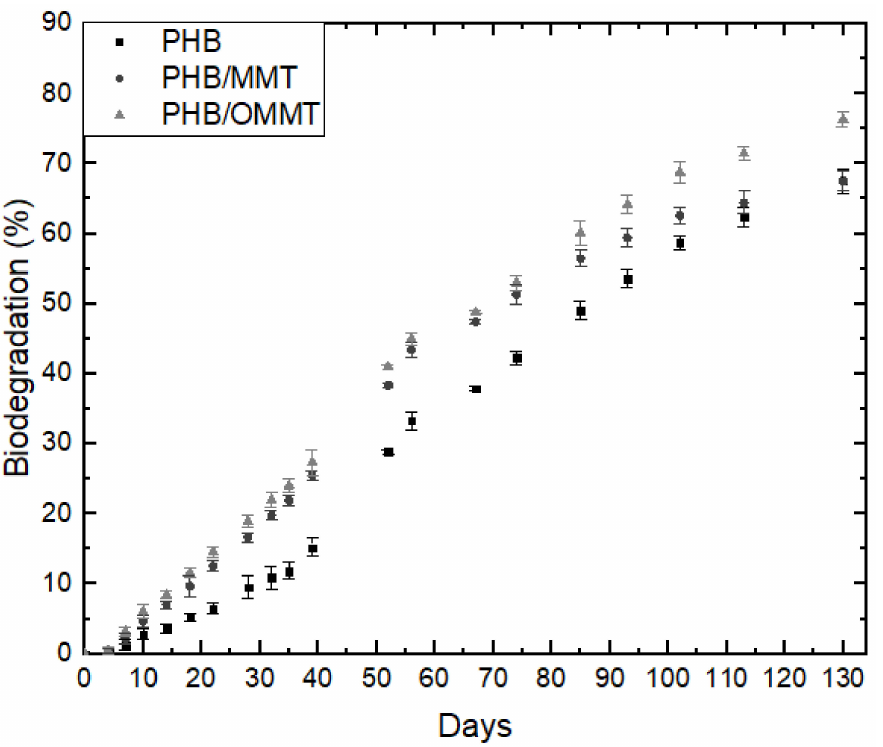
Figure 5. Biodegradation rates of microcapsules of PHB, PHB/MMT, and PHB/OMMT with urea en-